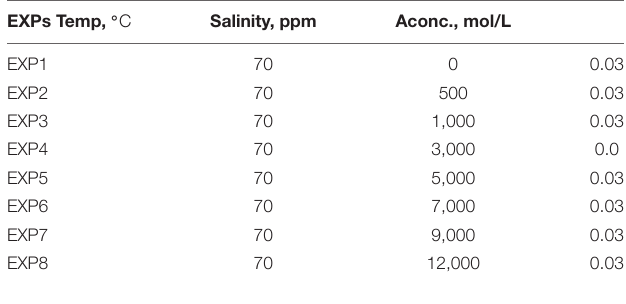
TABLE 10 | NaOH concentration trend study experiment design.